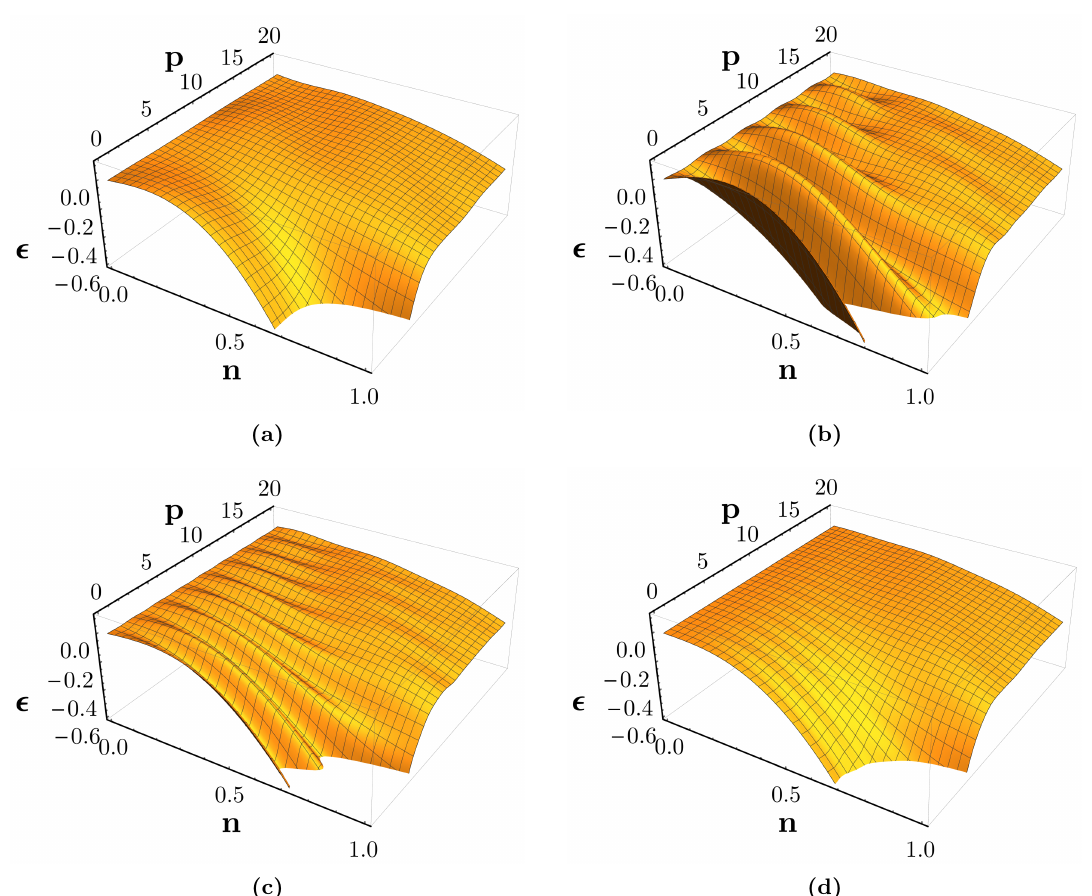
Figure 9 . Energy spectrum ε ( n , p ; t ) for large charged excitations plotted as a function of n and p for: (a) t = 1 ; (b) t = 3 (c) t = 5 ; (d) t = 7 ( ν = 1 / 3